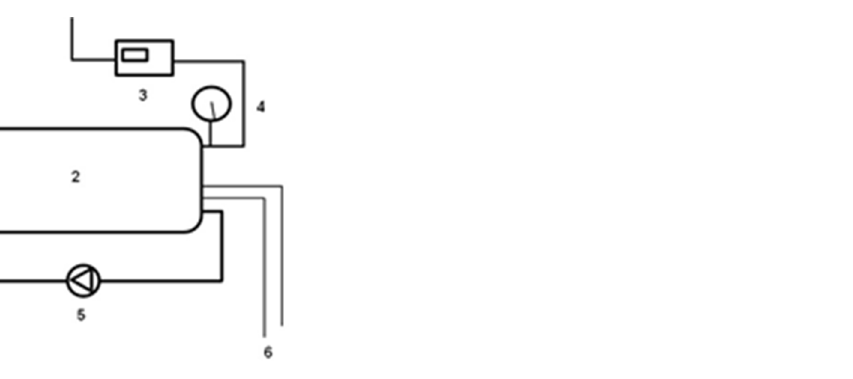
Figure 1. Scheme of a bioreactor: (1) temperature meter, (2) 44 dm 3 reactor, (3) gas quantity meter, (4) pressure gauge, (5) centrifugal pump, (6) liquid inflow and outflow from the recirculation thermostat.